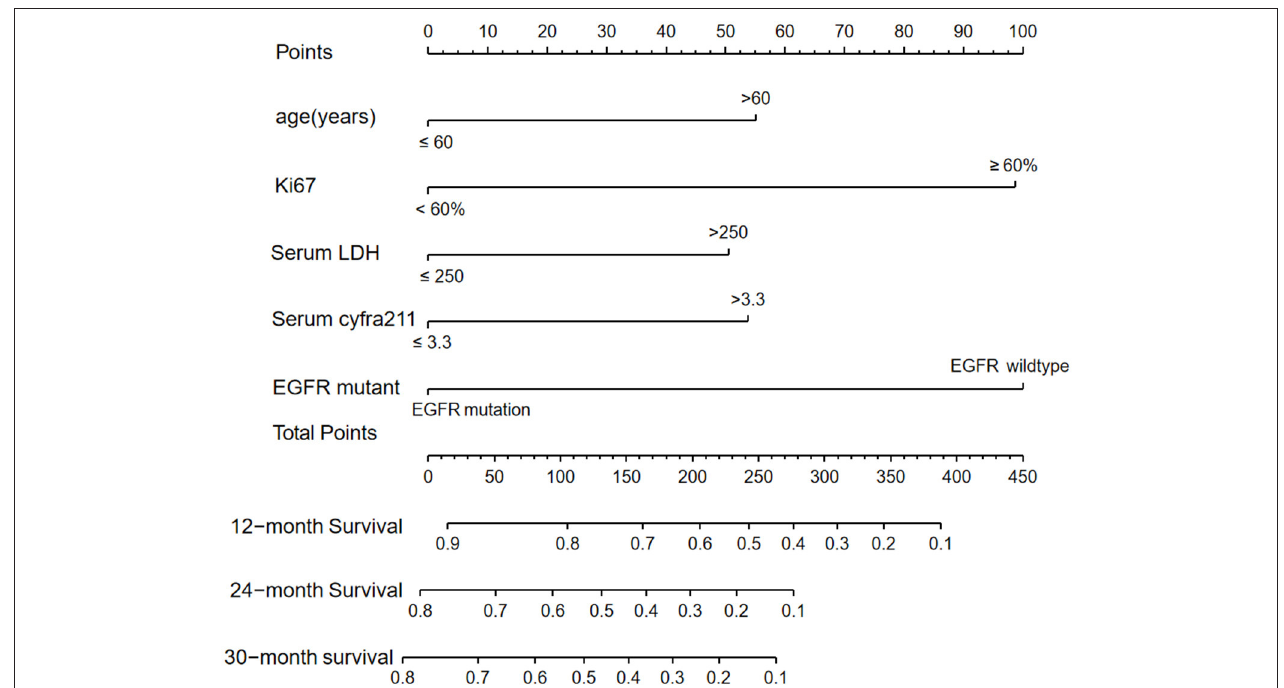
FIGURE 4 | Nomogram predicting the 12-, 24- or 30-month median survival outcomes for NSCLC patients with or without EGFR mutations and treated with first-line therapy. The prediction was done by adding the total points for all the indicators for each variable. For instance, the factor of Ki-67 was vertically downward to the scale labeled “Total Points” axis, and each indicator score was added in total points. Finally, those three factors get the total scores on the “Total Points” axis to the bottom scale and are used to predict the 12-, 24-, and 30-month overall survival probability. EGFR, epidermal growth factor receptor; NSCLC, non-small cell lung cancer.